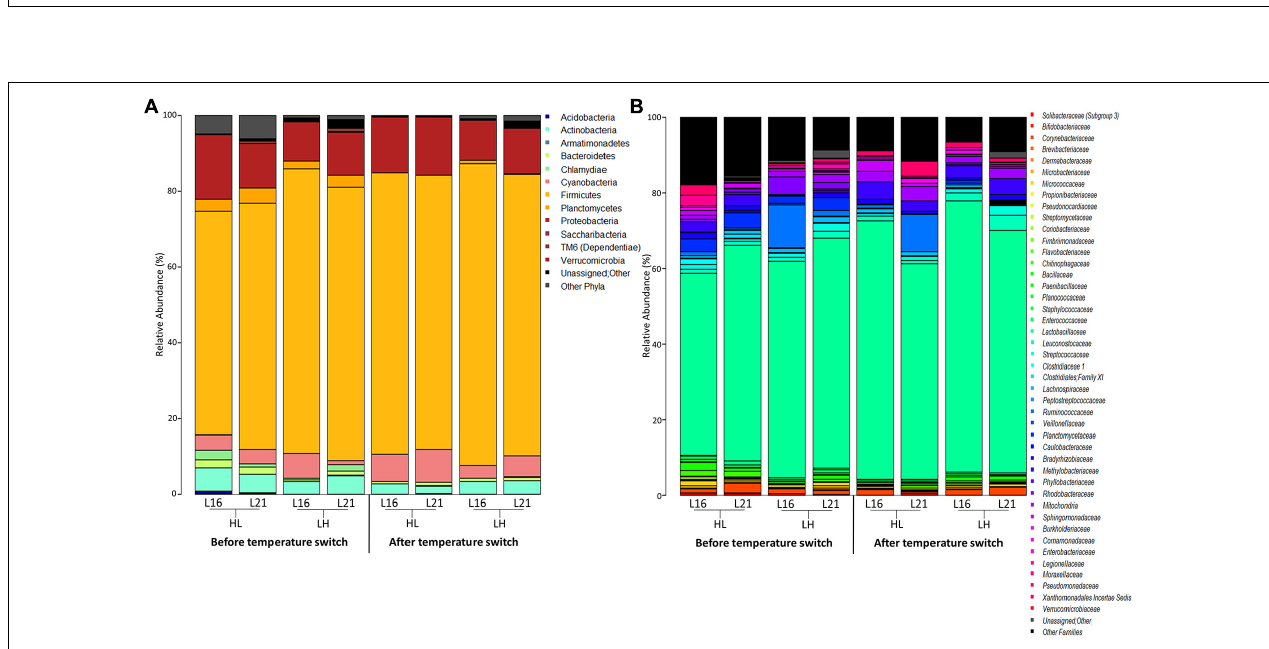
FIGURE 4 | Microbiota composition of distal gut content of gilthead sea bream fed with the experimental diets and exposed to temperature switch over 121 days. Bar plot summarizing the microbiota composition at phylum (A) and family level (B) of fish intestinal content. Only phyla with a relative abundance ≥ 0.1% in at least 10 samples, and families with relative abundance ≥ 0.1% in at least 10 samples are represented. L16, low-lipid 16% diet; L21, high-lipid 21% diet; HL, constant temperature exposure to high (H) temperature of 23 ◦ C before, and to low (L) temperature of 17 ◦ C after, temperature switch; LH, constant temperature exposure to low (L) temperature of 17 ◦ C before, and to high (H) temperature of 23 ◦ C after, temperature switch. Temperature switch occurred on day